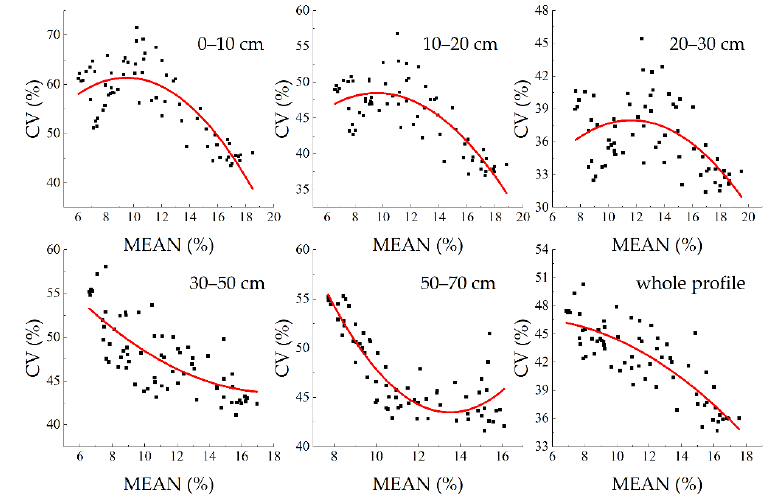
Figure 6. Mean and coefficient of variation (CV) of soil moisture at different layers.